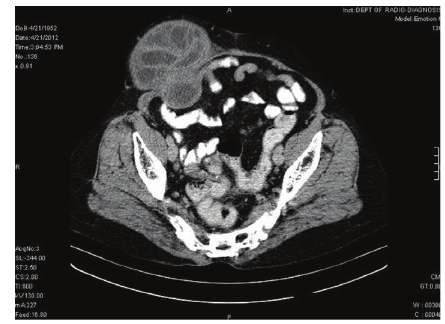
Figure 1: Preoperative swelling in right paraumbilical region.